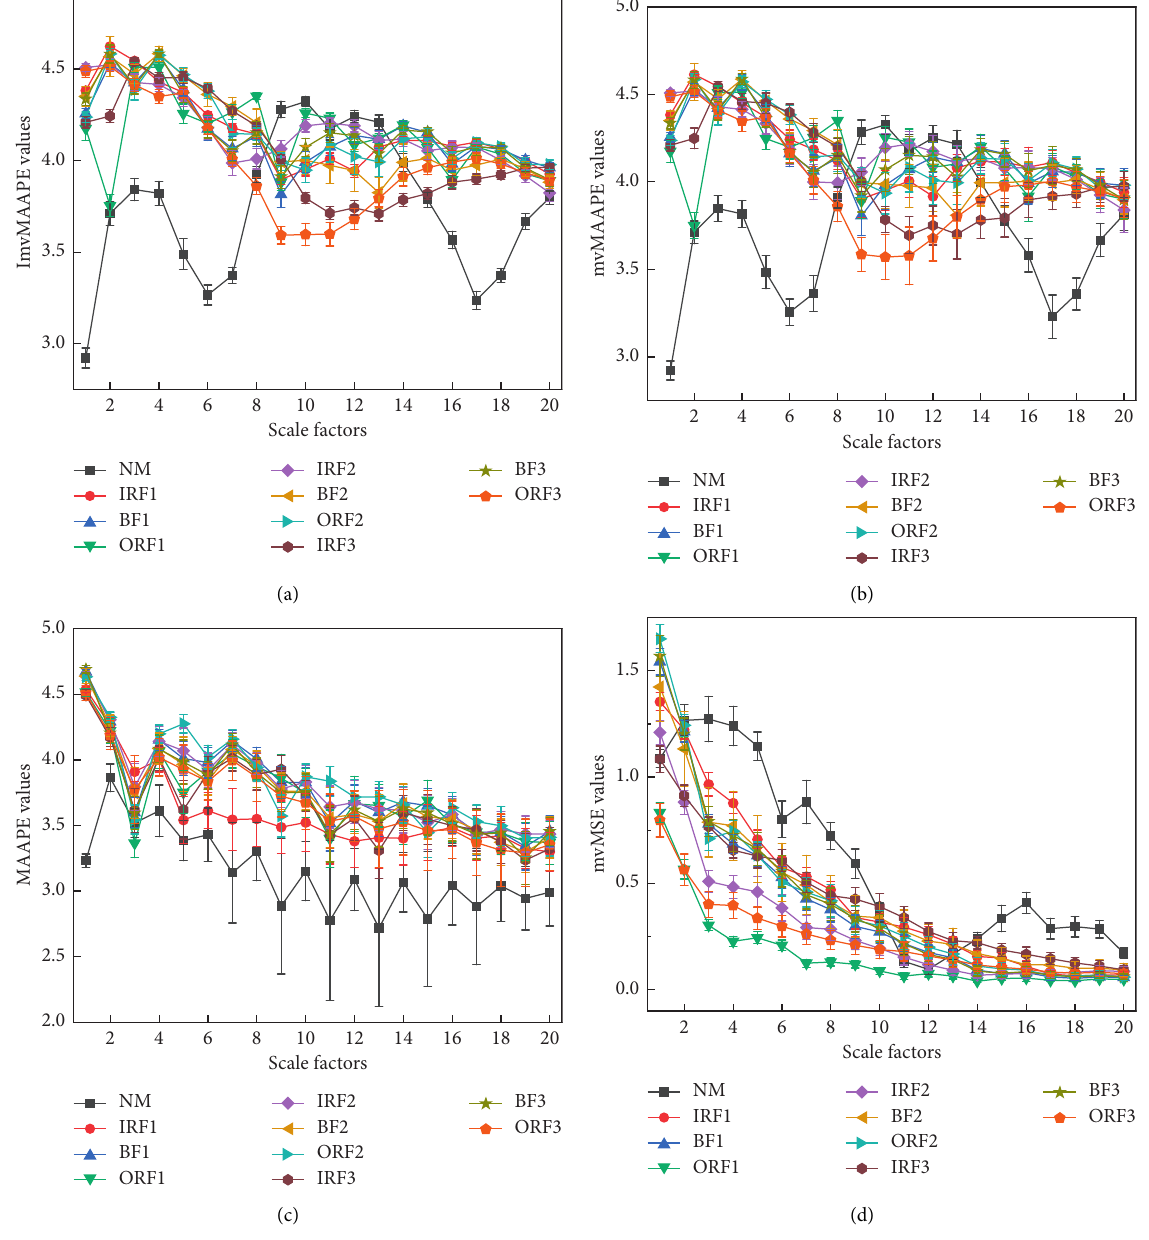
Figure 19: Gearbox entropy analysis diagram of the five multiscale analysis methods: ImvMAAPE (a), mvMAAPE (b), MAAPE (c), and mvMSE